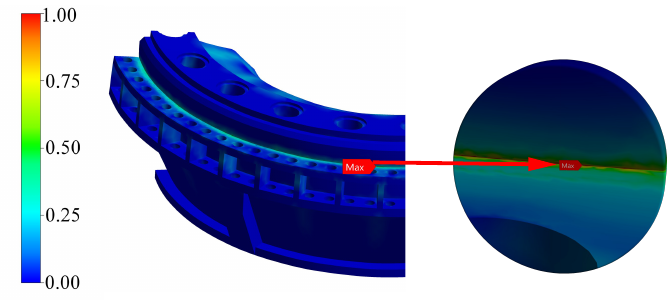
Figure 18. The maximum stress of the bottom ring during turbine start-up. During the start-up process in turbine mode, the pressure load applied to the inner surface of the non-rotating structure lifts the head cover, presses down the bottom ring, and stretches all the stay vanes of the stay ring, and the maximum stress occurs on the trailing edge fillet of a stay vane of the stay ring. The maximum stress of the head cover is located at the round hole of a reinforcing plate, which has a lower stiffness than other reinforcing plates. and the maximum stress of the bottom ring is on the connecting flange of the bottom ring. To analyze the variation of the maximum stresses of the non-rotating structures with time, Figure 19 compares the normalized maximum stresses during turbine